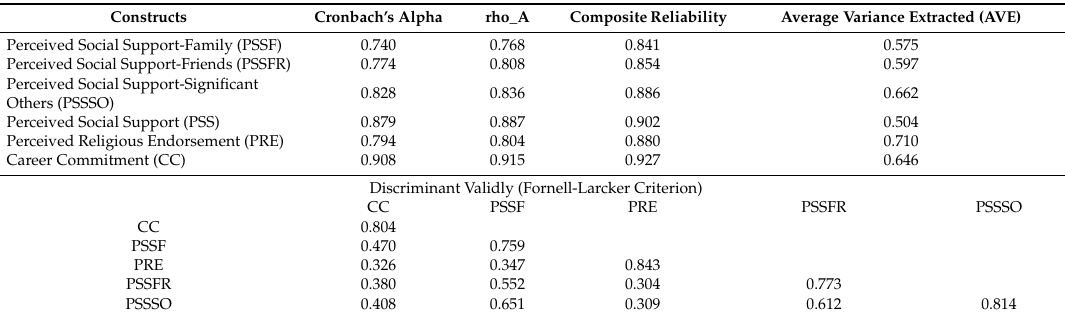
Table 2. Measurement model indicators.